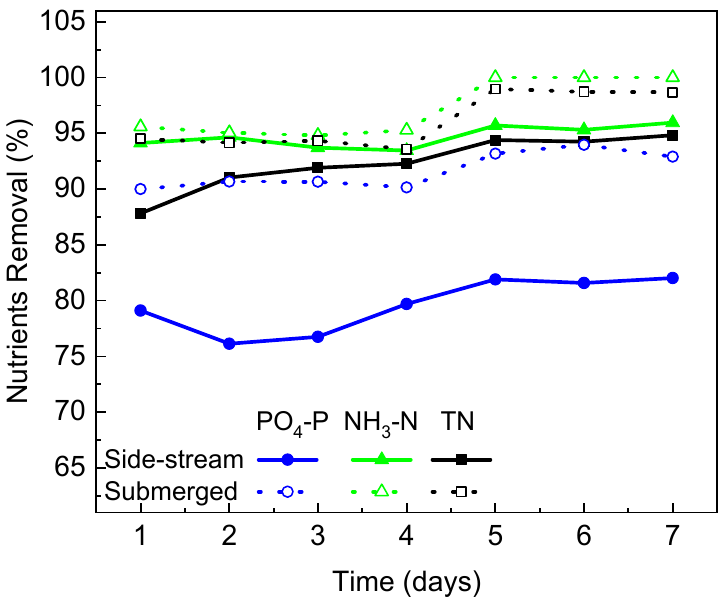
Figure 5. Comparison of nutrients removal efficiencies in the PBR with different FO configurations during semi-continuous operation.